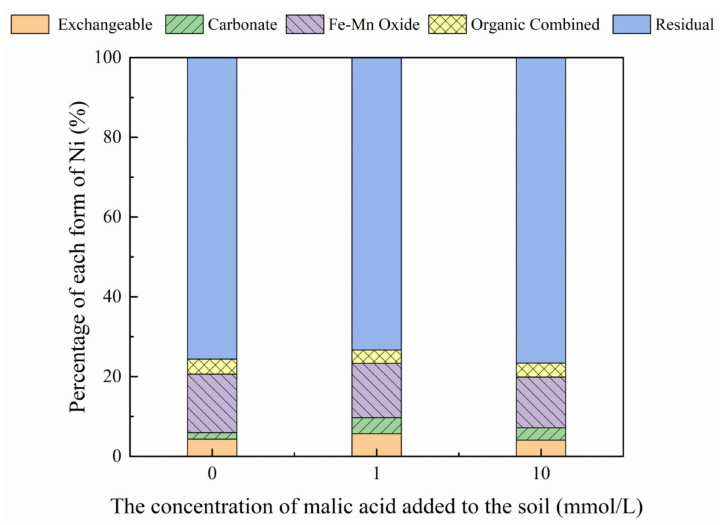
Figure 7. Distribution of different Ni forms after the addition of malic acid (0, 1, 10 mmol/L) to the air-dried mine